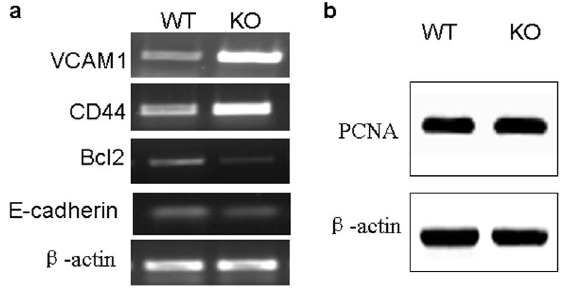
Figure 4. Gpr48 deficiency altered the abilities of cell adhesion. (a) The expressions of ICAM-1, CD44, E-cadherin and Bcl-2 were determined by RT-PCR. The transcript levels of ICAM-1 and CD44 were increased while the expressions of E-cadherin and Bcl-2 were decreased in Gpr48 KO mice compared with the WT mice. (b) Western blot analyses demonstrate PCNA expression is not changed in Gpr48 KO and WT adult mice.